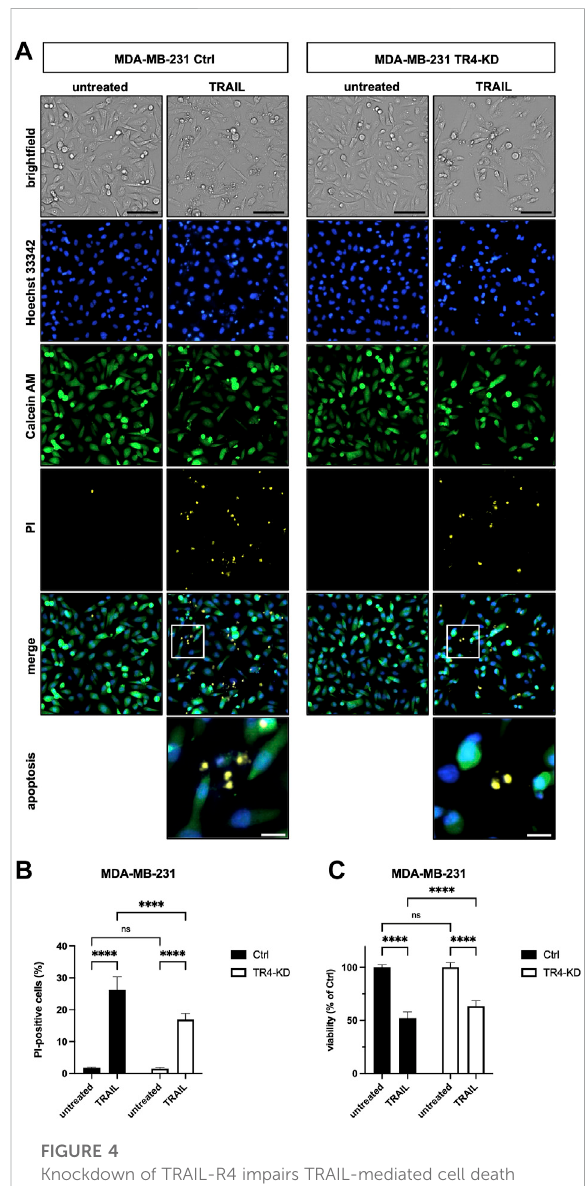
FIGURE 4 Knockdown of TRAIL-R4 impairs TRAIL-mediated cell